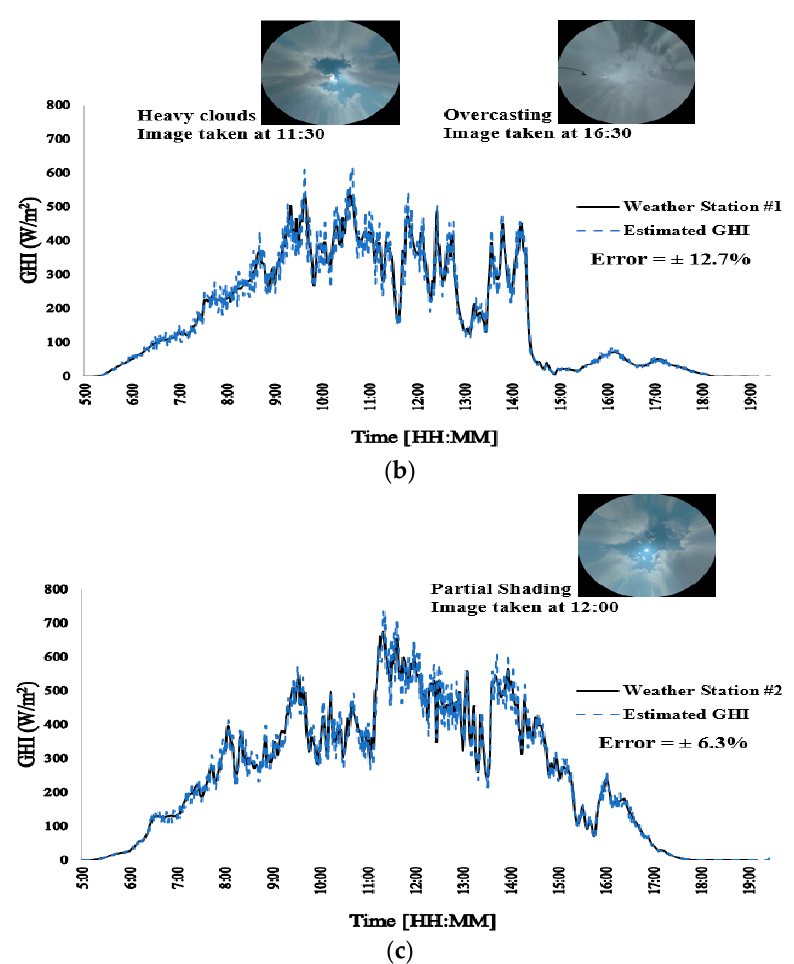
Figure 7. Output results of the estimated vs actual weather station GHIs under different shading conditions: ( a ) partial shading and clear sky, taken from weather station #1 (21 July 2022), ( b ) over- casting (heavy clouds), taken from weather station #1 (22 July 2022), and ( c ) partial shading, taken from weather station #2 (23 July 2022). (The sky images were taken from the nearest TSI, TSI-A for weather station #1 and TSI-D for weather station #2).